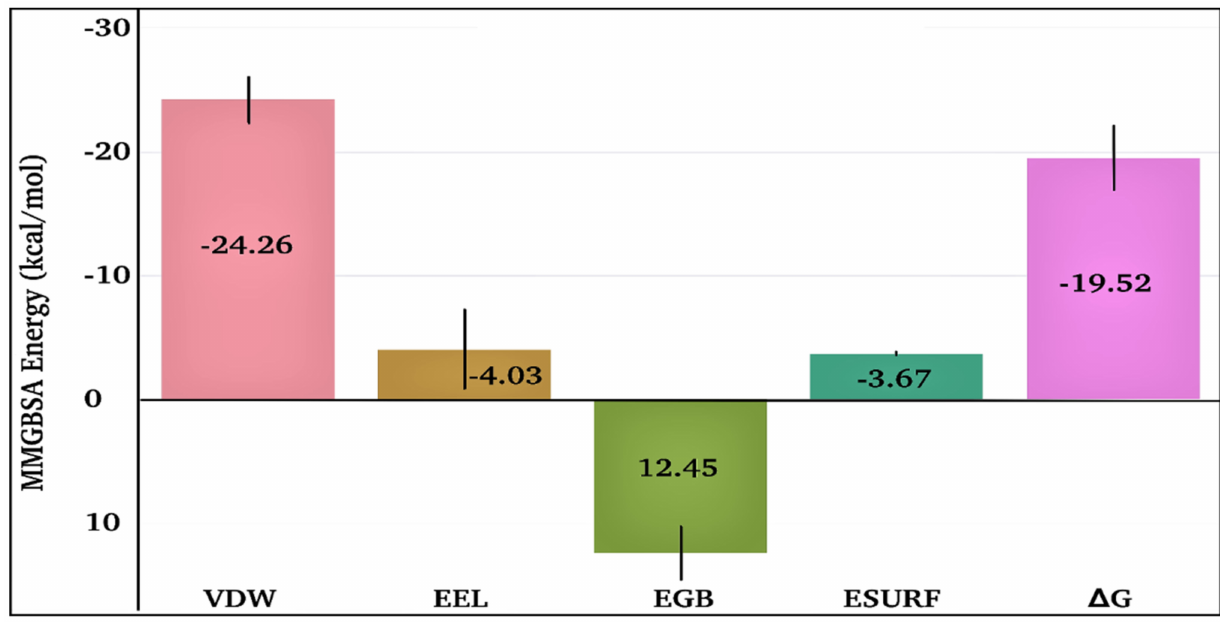
Figure 8. Individual energy components contribute to the total MMGBSA binding energy for the TQ-squalene monooxygenase complex. VDW, EEL, EGB, ESURF, and ∆ G represent van der Waals, electrostatics, polar solvation, nonpolar solvation, and total MMGBSA binding energy,